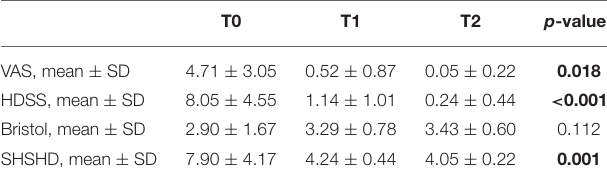
TABLE 2 | Scores values, stratified for time of